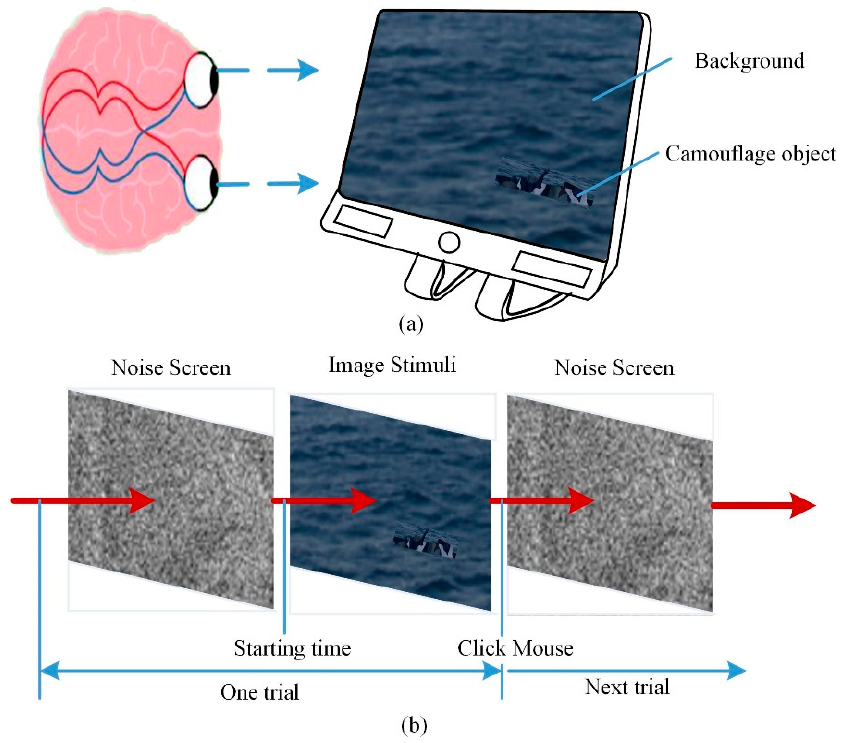
Figure 2. Schematic of the experimental procedure used to validate the developed method: ( a ) the camouflaged image showed in the background on the screen; ( b ) the workflow of each